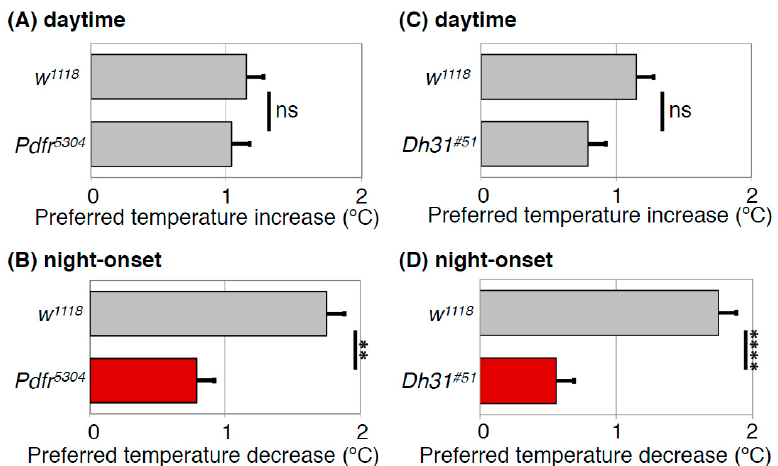
Figure 5. PDFR and DH31 regulate the night-onset TPR. Comparison of daytime TPR ( A , C ) or night-onset TPR ( B , D ) between w 1118 and Pdfr mutant ( Pdfr 5304 ) ( A , B ) or Dh31 mutant ( Dh31 #51 ) ( C , D ) flies. Both Pdfr 5304 and Dh31 #51 flies show significantly dampened night-onset TPR ( B , D ), while both exhibit robust increases in preferred temperature during the daytime ( A , C ). The data suggest that both PDFR and DH31 are responsible for the night-onset TPR. The graphs are modified from Goda et al. 2016, Figures 1 and 3 [40]. t-test: **: p < 0.01, ****: p < 0.0001.